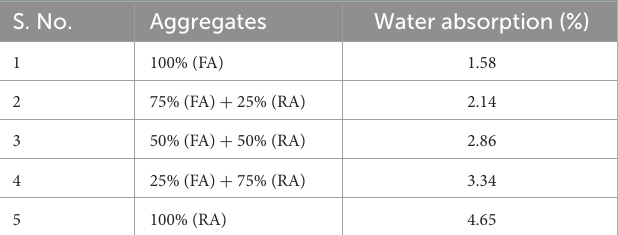
TABLE 1 Water Absorption at different percentages of recycled aggregates. S.